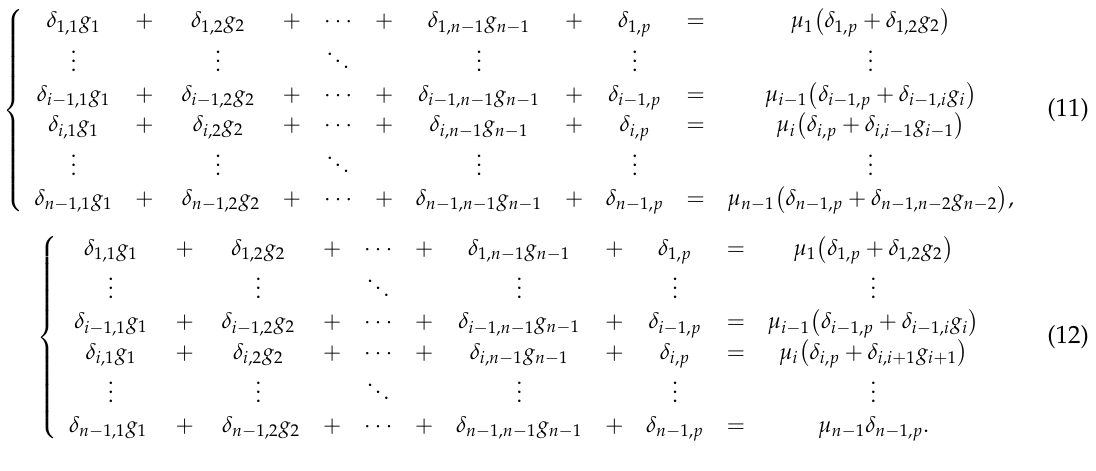
Table 1. Pseudo-code of modified hinged plate method. Algorithm: The load lateral distribution influence